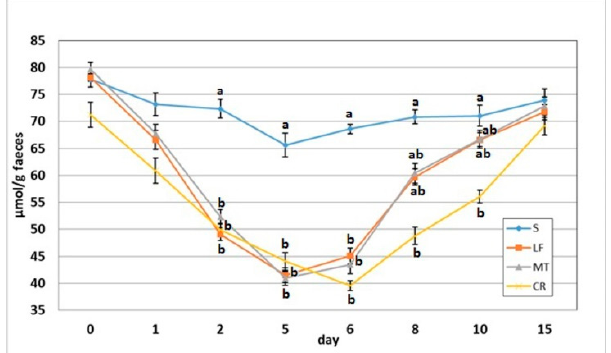
Figure 5. Total short-chain fatty acid concentration in faeces of rats fed diets supplemented with lactoferrin, melittin or cecropin A. Experimental factor in particular groups: S—control standard